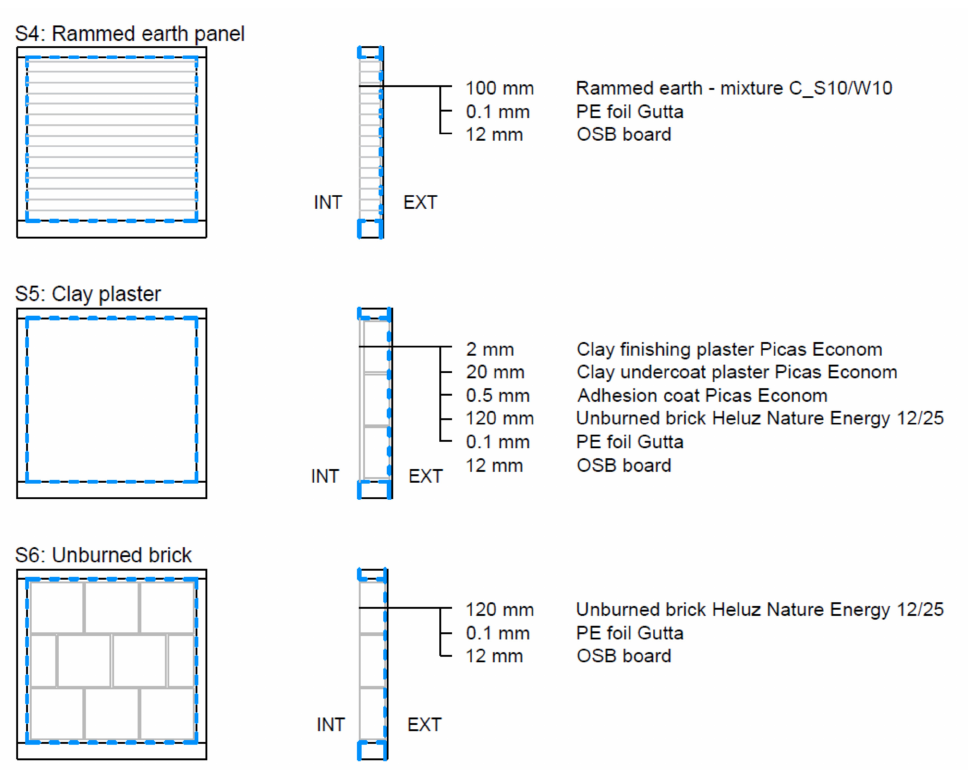
Figure 5. Traditional wall elements: test samples S1–S3.